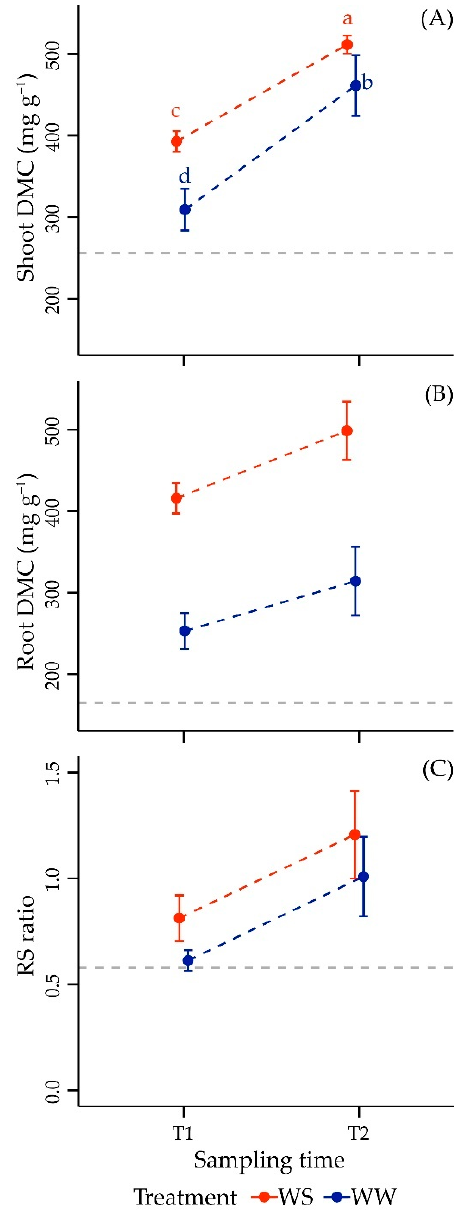
Figure 3. Mean values ± standard deviation of dry matter content (DMC) of shoot and root (panels A and B , respectively), and of RS ratio (panel C ) in Merlot vines under well-watered (WW) and water stress (WS) conditions at sampling times T1 and T2 (237 and 260 DOY). The horizontal dotted line indicates the value of the variables at T0 (205 DOY). Different letters correspond to statistically significant differences ( p < 0.05).